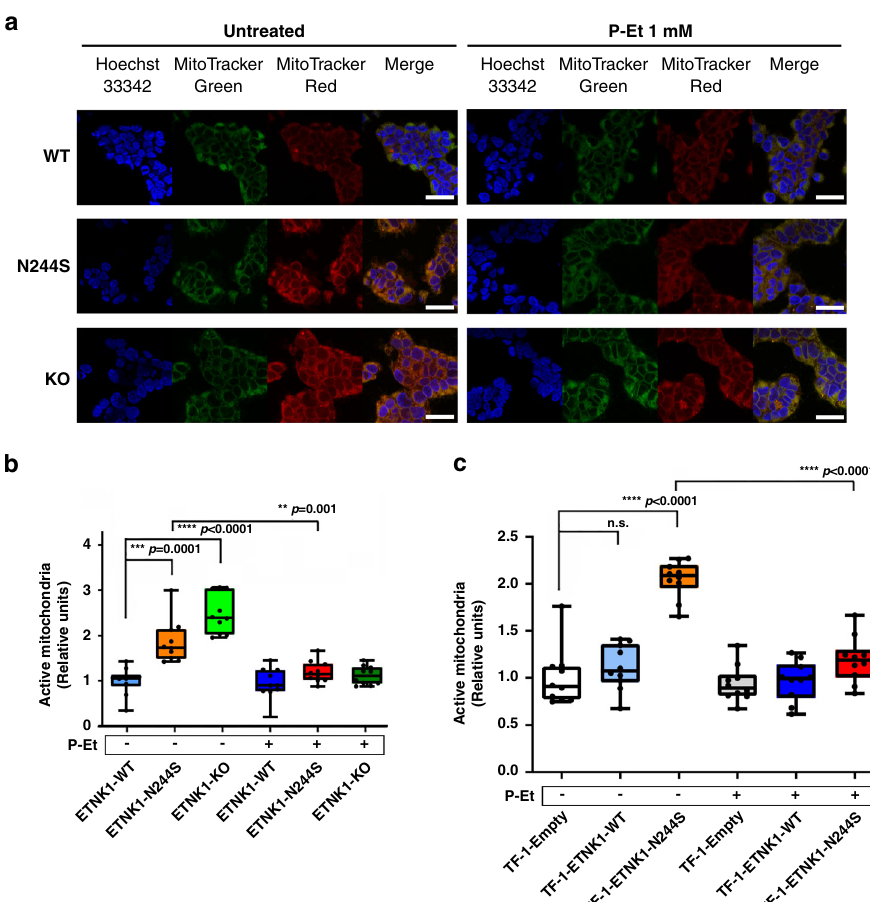
Fig. 2 Mitochondria activity in the absence and presence of P-Et. a Confocal microscopy of MitoTracker Red/Green signal in ETNK1-WT, N244S, and KO CRISPR cell lines in the absence (left) and presence (right) of 1 mM P-Et for 24h. At least 200 cells were analyzed. The scale bar corresponds to 40 µ m. b Boxplots showing the MitoTracker Red-to-Green signal ratio of ETNK1-WT, N244S, and KO CRISPR cell lines normalized on ETNK1-WT in the absence and in presence of 1mM P-Et for 24h. The boxplots delimit the interquartile range; the central bar represents the median; the whiskers extend from minimum to maximum ( n = 10 representative fi elds). Statistical analyses were performed using one-way ANOVA with Tukey ’ s post-hoc test. c MitoTracker Red-to- Green signal in the absence and in presence of 1 mM P-Et (for 24h) in the myeloid TF-1 model. Statistical analyses were performed using one-way ANOVA with Tukey ’ s post-hoc test. The boxplots delimit the interquartile range; the central bar represents the median; the whiskers extend from minimum to maximum ( n = 10 representative fi elds). At least 200 cells were analyzed. Source data are provided as a Source data fi